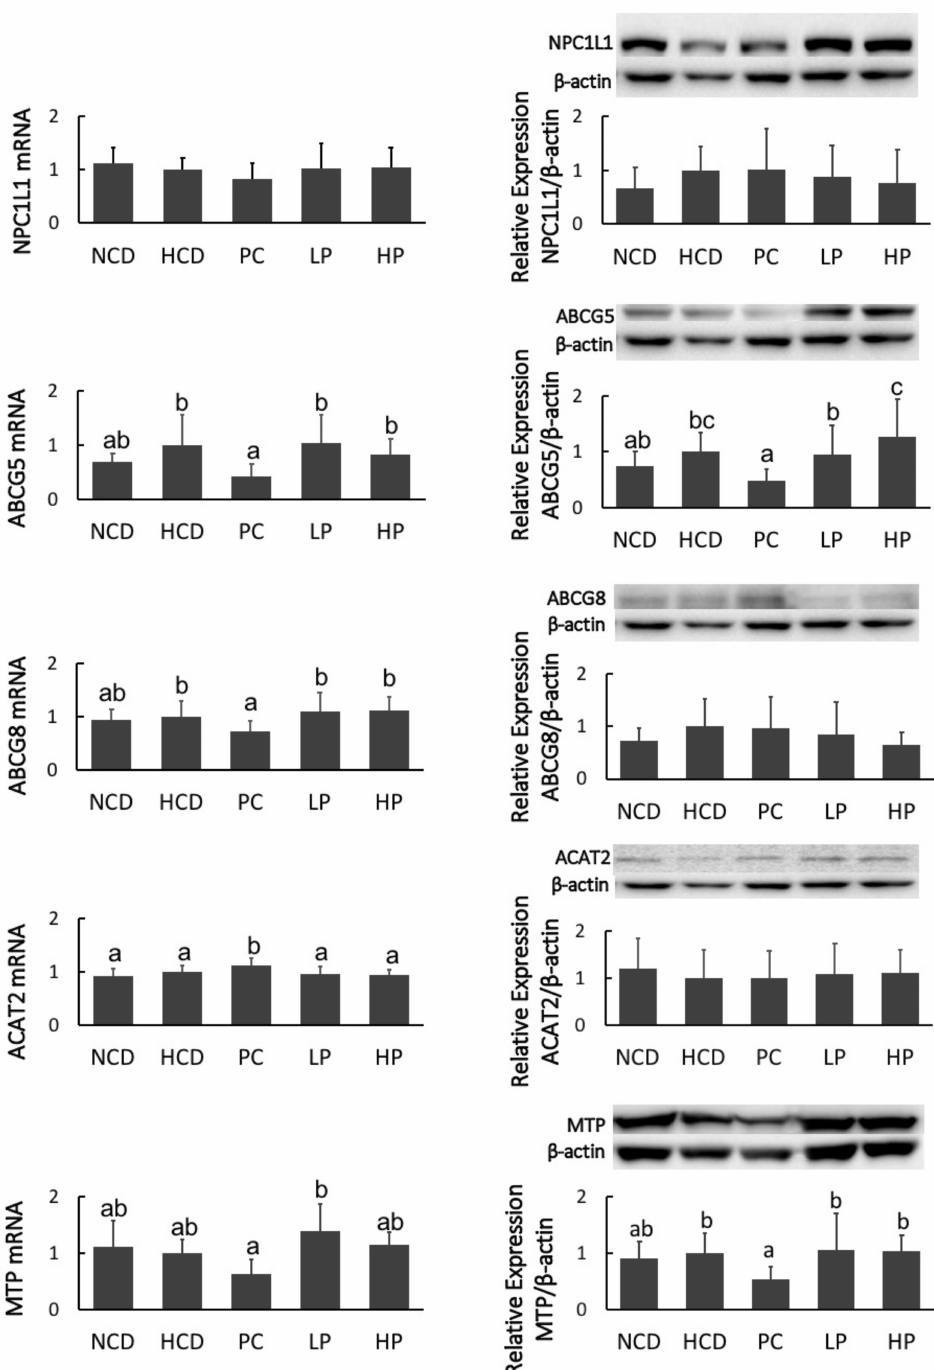
Figure 8. mRNA levels and protein mass of Niemann-Pick C1–like 1 protein (NPC1L1), members 5 and 8 of the ATP binding cassette transporter subfamily G (ABCG5 / 8), acyl-CoA: cholesterol acyltransferase 2 (ACAT2), and microsomal triacylglycerol transport protein (MTP), in hamsters fed one of five diets: NCD, no cholesterol diet; HCD, high cholesterol diet containing 0.1% cholesterol; PC, high cholesterol diet containing 0.5% cholestyramine; LP, high cholesterol diet containing a low dose (0.1%) soybean germ phytosterols (SGP); HP, high cholesterol diet containing a high dose (0.2%) soybean germ phytosterols (SGP). n = 8 for each group. a,b,c = means with di ff erent superscript letters di ff er significantly at p <